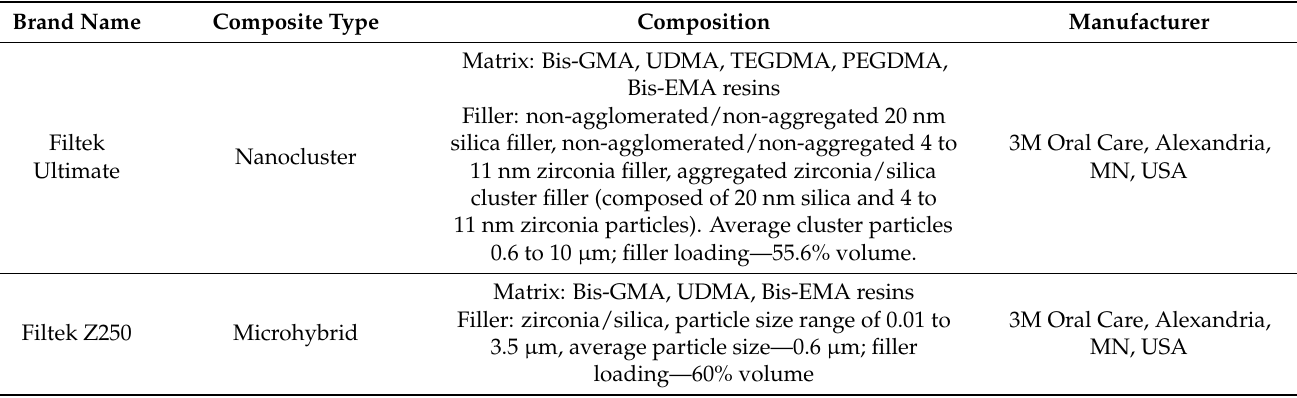
Table 1. Composition of the resin composites used in the